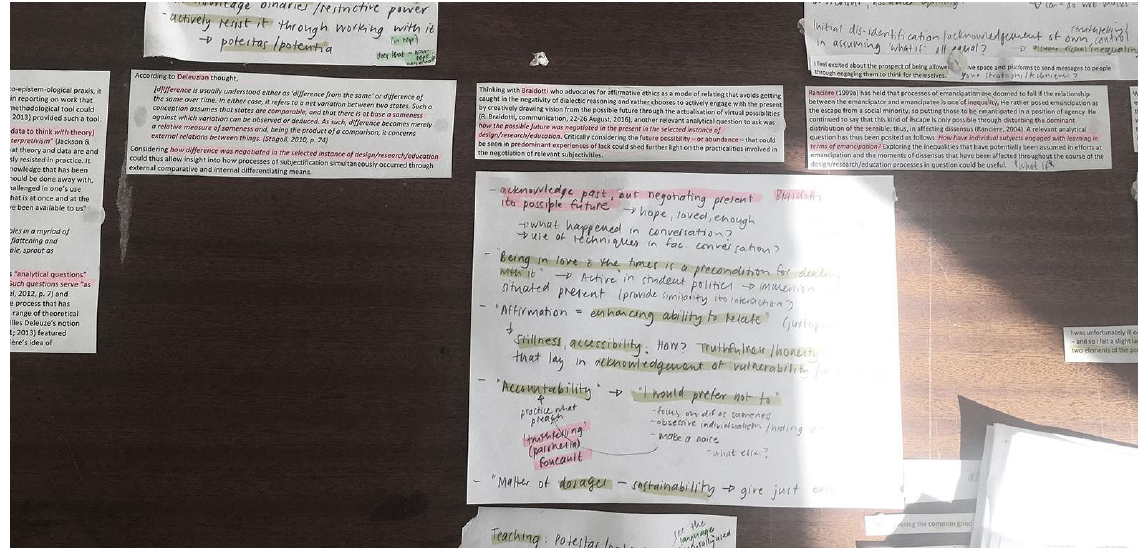
Figure 4 : Excerpt from follow-up discussion map (Source: Perold-Bull,